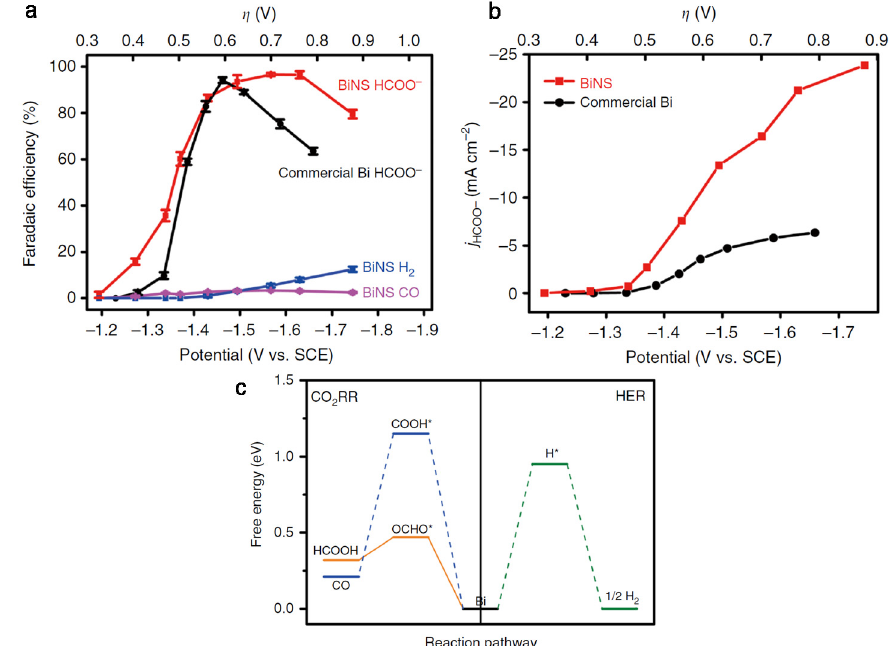
Figure 4. ( a ) Potential-dependent FEs of HCOO − , CO, and H 2 on Bi nanosheets (NSs; BiNS) in comparison with the FE of HCOO − on commercial Bi nanopowder; ( b ) potential-dependent HCOO − partial current density on BiNS and commercial Bi nanopowder; and ( c ) free-energy diagram for HCOO − , CO, and H 2 formation on the Bi(001) plane [56]. Copyright 2018, Nature. Catalysts 2020 , 10 , x FOR PEER REVIEW